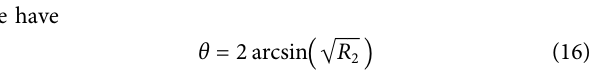
Frontiers in Physics |